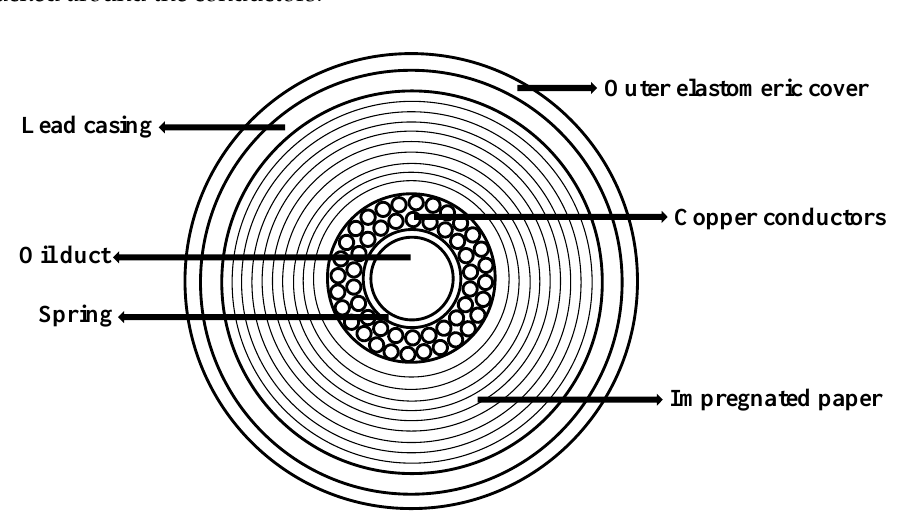
Figure 1. Components of a typical high-voltage electrical cable.